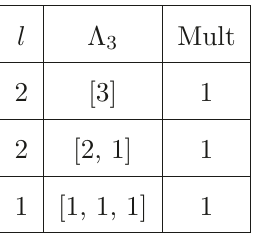
Table 1 . Results for n = 3 fields and k = 2 derivatives.